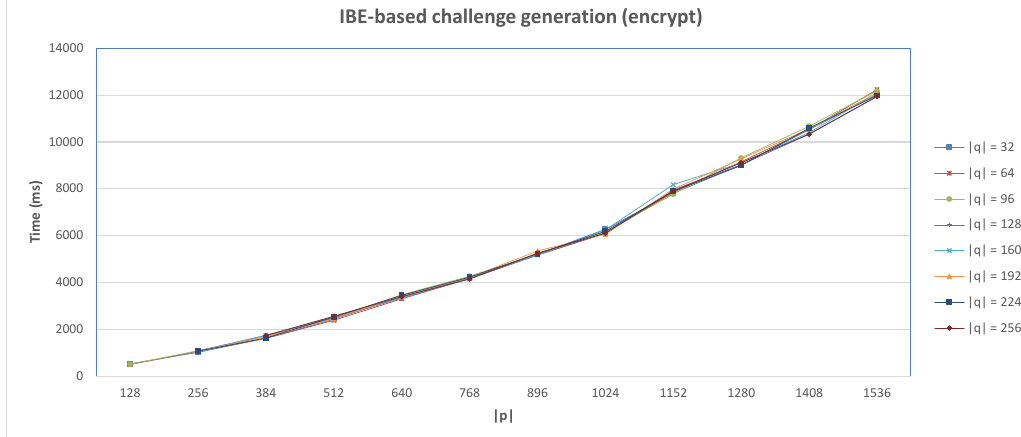
Figure 6. IBE-based Anonymous DCapBAC. Challenge generation performance.